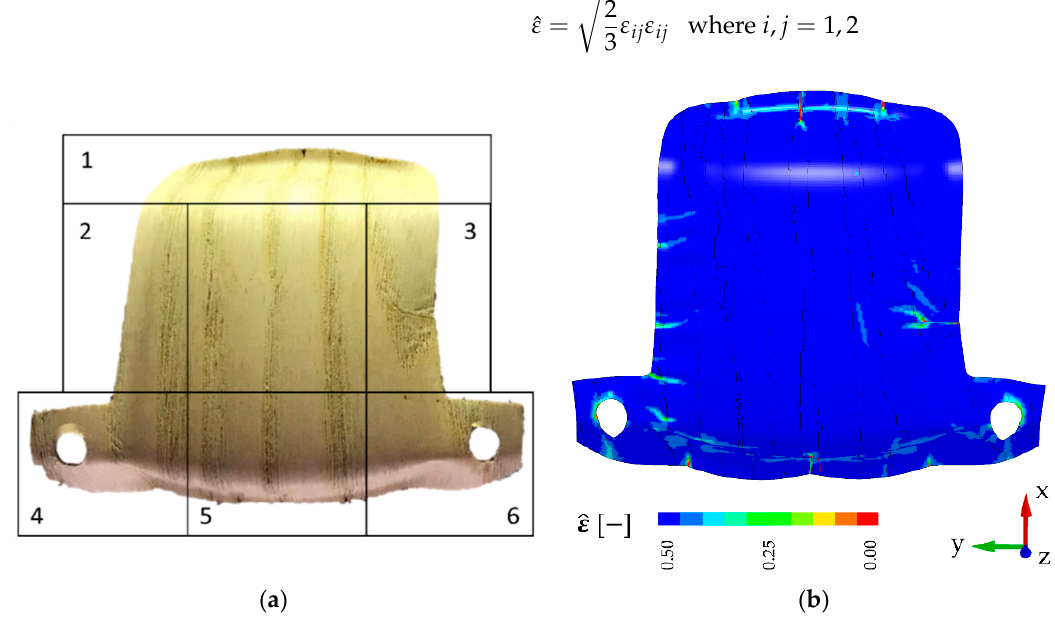
Figure 9. Forming results of sample 𝟏 ∥ . ( a ) Experiment; ( b ) simulation with output of equivalent strain.